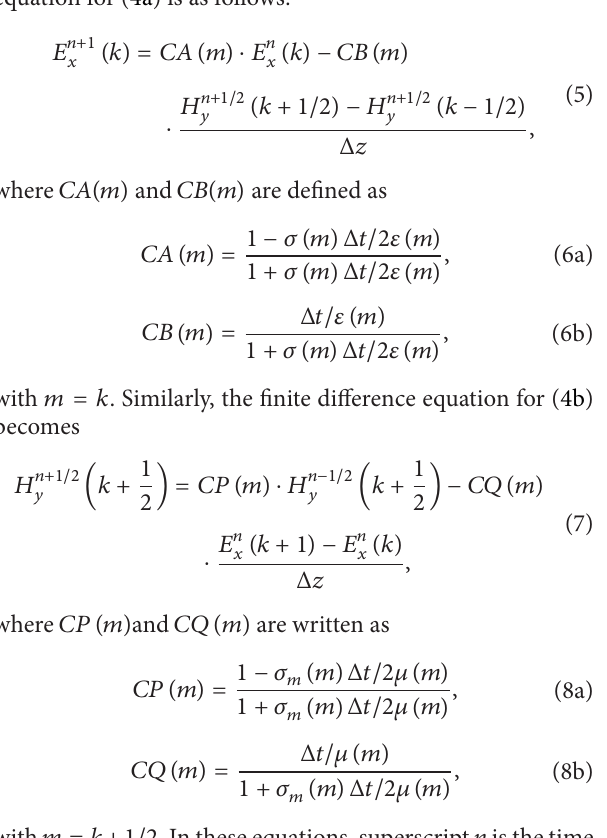
Figure 2: The FDTD model for the conducting surface